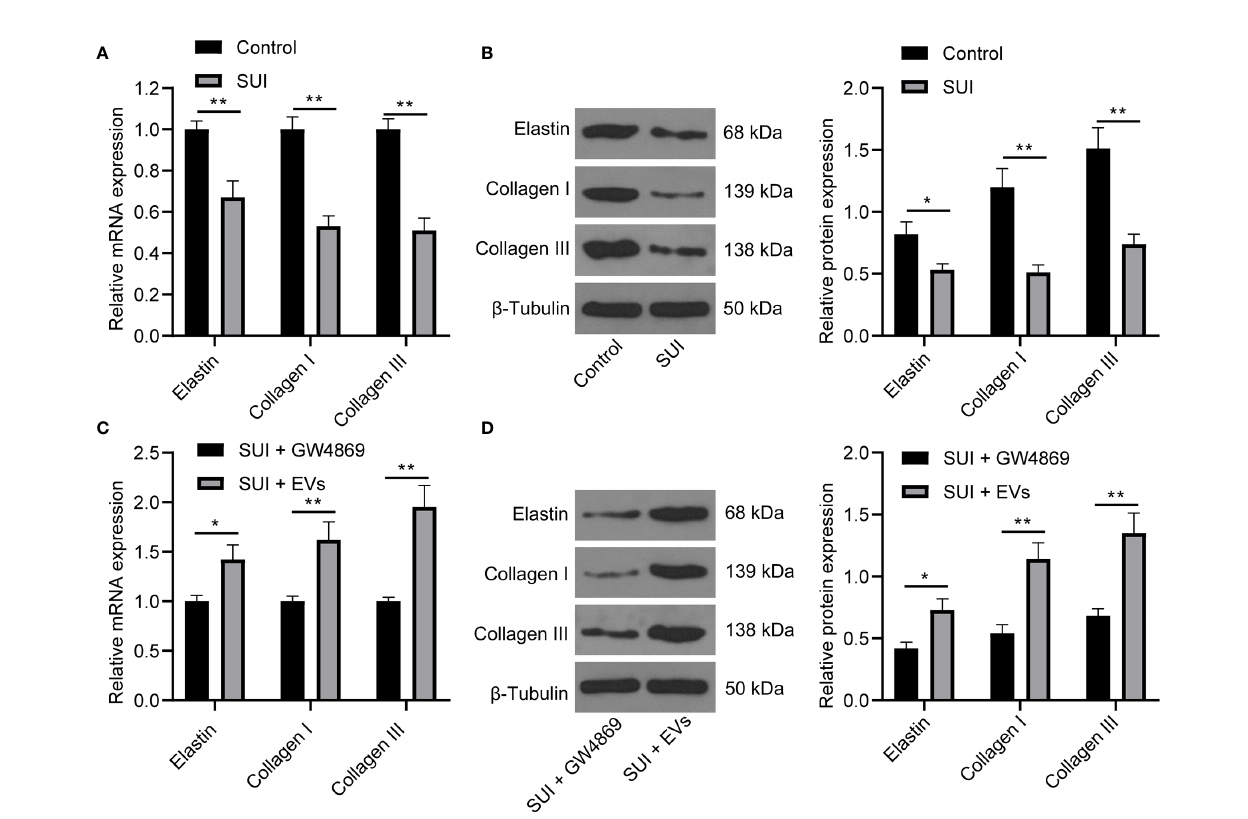
FIGURE 2 | Effects of ADSCs-EVs on ECM remodeling of SUI primary fi broblasts. (A, B) . Expression levels of Elastin, Collagen I, and Collagen III in SUI primary fi broblasts determined by RT-qPCR and Western blot assay. (C, D) . Expression levels of Elastin, Collagen I, and Collagen III in SUI primary fi broblasts with ADSCs- EVs treatment determined by RT-qPCR and Western blot assay. GAPDH was used as the mRNA reference gene in the RT-qPCR data, and 2 − DD Ct was used for quantitative analysis; the Western blot assay data was normalized to the background value and the control b -Tubulin band value. N = 3. The differences between two groups were analyzed by Student ’ s t − test (A – D) . * P < 0.05; ** P <